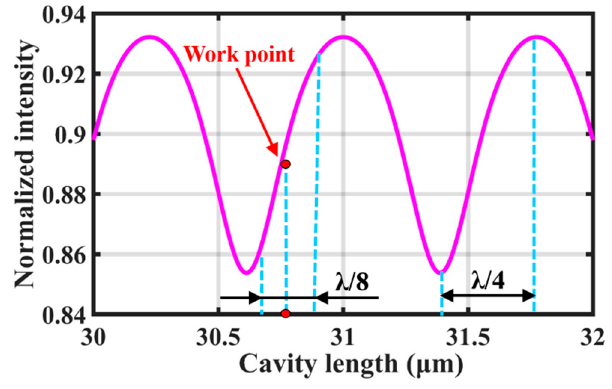
Figure 6. Relationship between normalized intensity and cavity length.